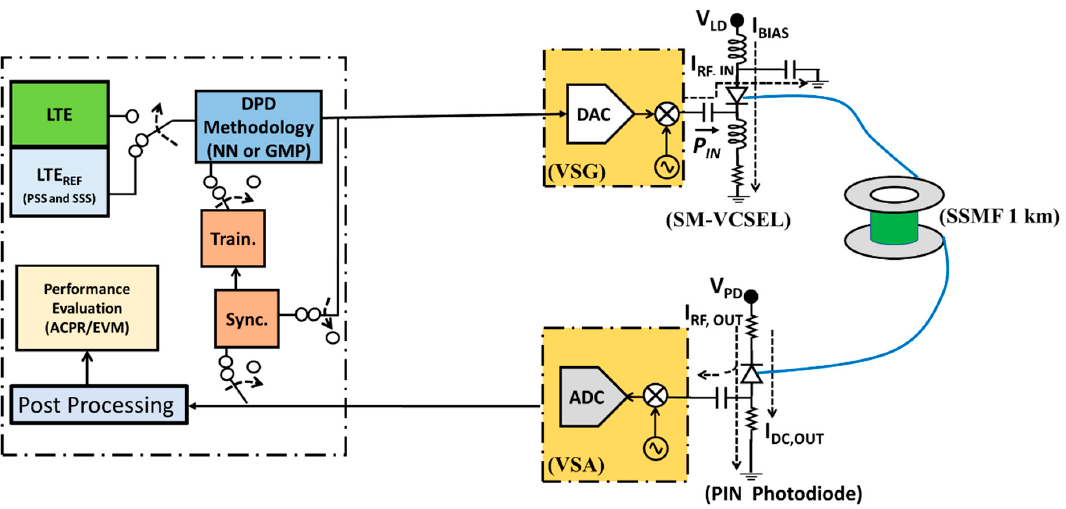
Figure 6. Block diagram of experimental testbed. DPD implemented for general LTE frames. DPD-NN or DPD-MP/GMP can be selected from the choice present in the simulator.